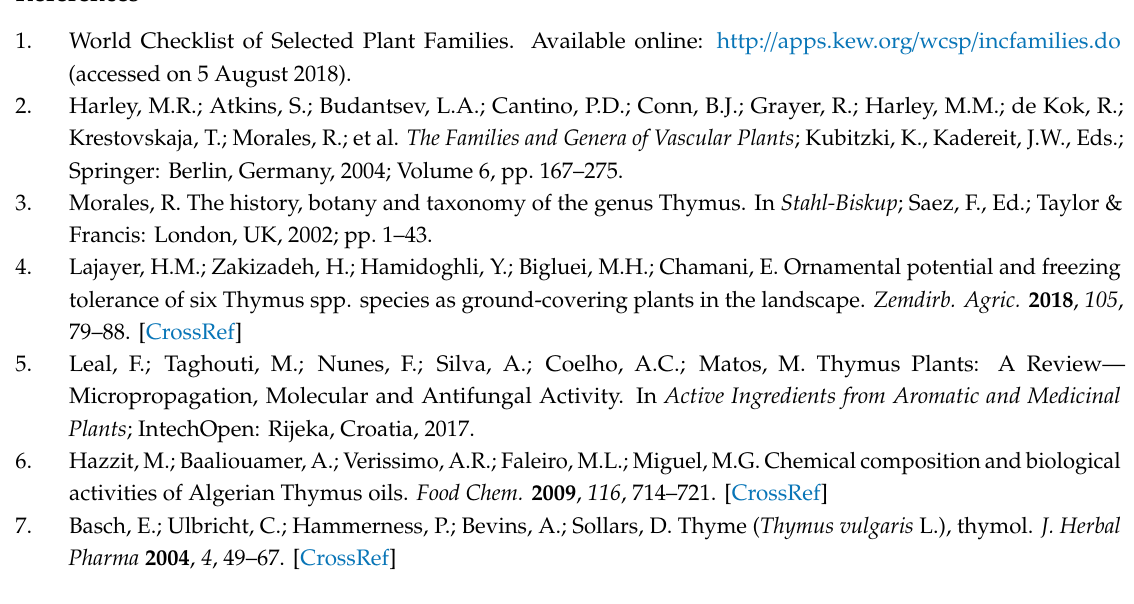
Figure S1: KEGG classification of unigenes for Thymus transcriptomes, Figure S2: Schematic representation of thymol and carvacrol biosynthetic pathway, Figure S3: GO enrichment of PSGs related to ecological adaptation in Thymus species, Table S1: Assembly statistics results of Thymus species, Table S2: Velvet / Oases assembly statistics results, Table S3: The number of full-length transcripts for three assemblers and five species, Table S4: Number of transcripts for each transcription factor genes families of Thymus species, Table S5: The contigs number of 11 genes involved in thymol and other monoterpene biosynthesis identified in Thymus transcriptomes, Table S6: Lengths of genes involved in thymol and other monoterpene biosynthesis identified in Thymus transcriptomes, Table S7: The unigenes subjected to positive